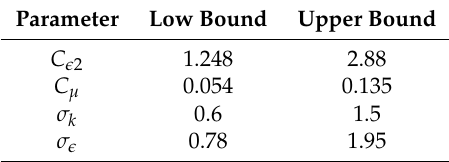
Table 3. Admissible range of the parameters in k − (cid:101) turbulence